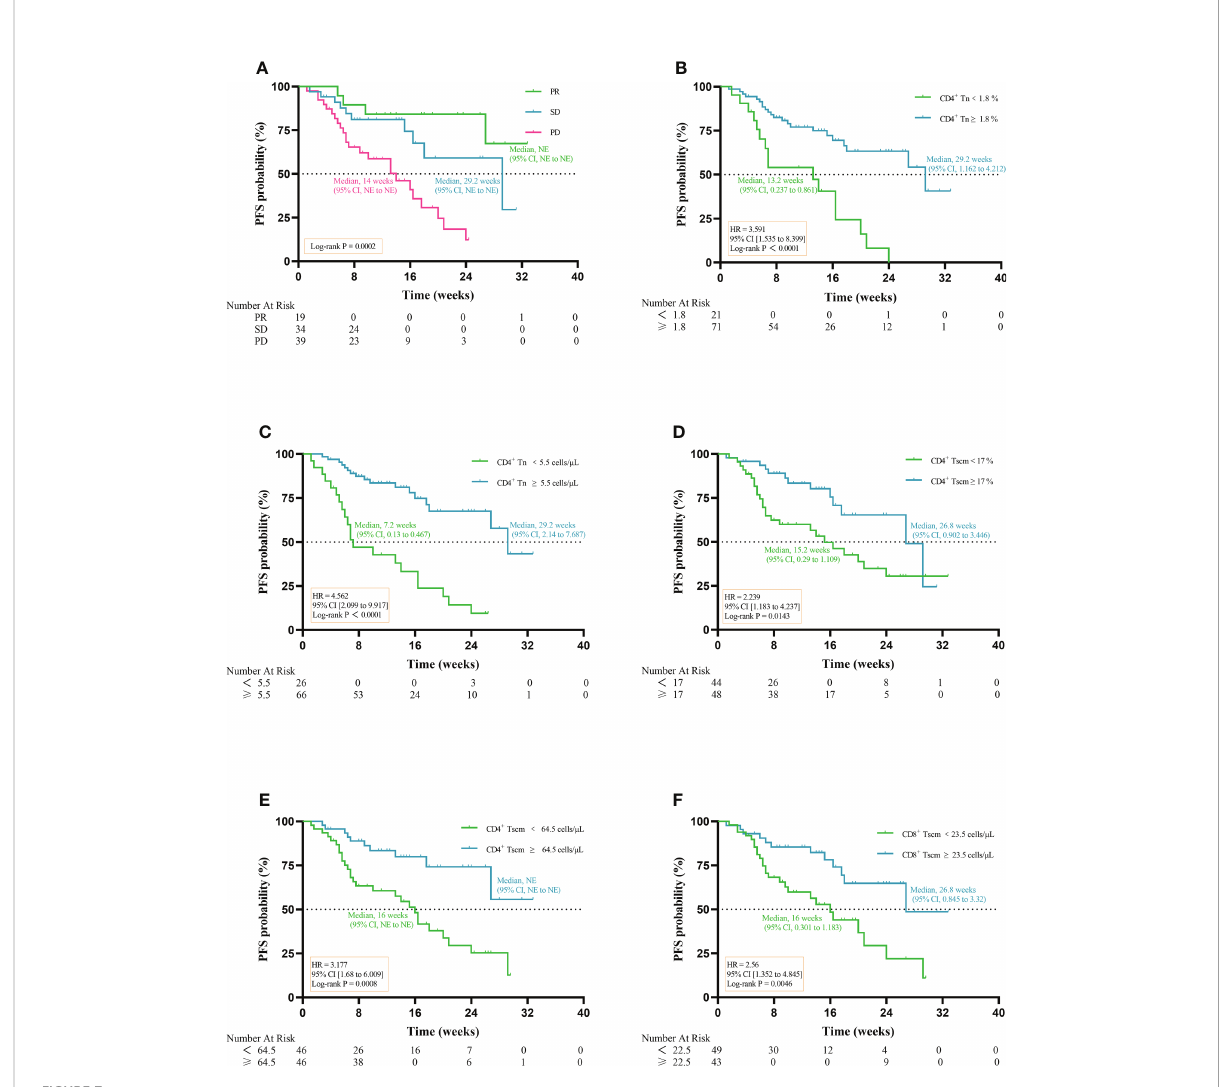
FIGURE 7 Prognostic impact of the baseline of Tn/Tm on PFS of NSCLCs: (A) Prognostic impact of PR, SD, and PD on PFS. (B) Prognostic impact in percentage of CD4 + Tn on PFS. (C) Prognostic impact in AC of CD4 + Tn on PFS. (D) Prognostic impact in percentage of CD4 + Tscm on PFS. (E) Prognostic impact in AC of CD4 + Tscm on PFS. (F) Prognostic impact in AC of CD8 + Tscm on PFS. NE: not